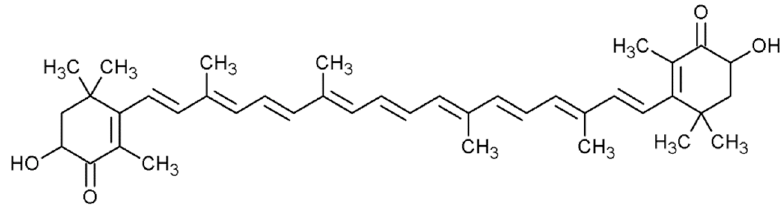
Figure 3. The structural formula of astaxanthin.